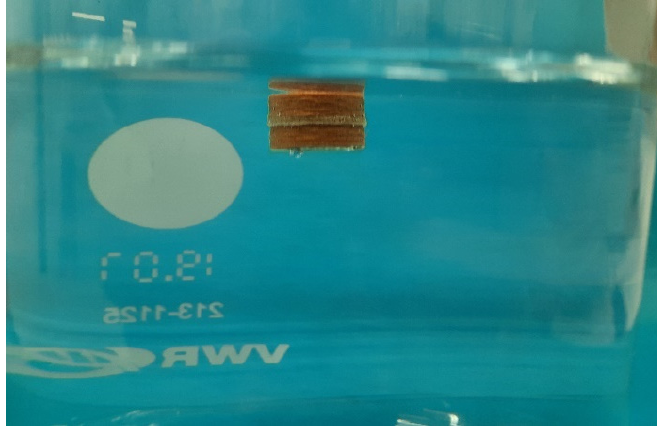
Figure 9. Floating properties of PP2 in 300 mL 0.1 N HCl, 37 ± 0.5 °C.